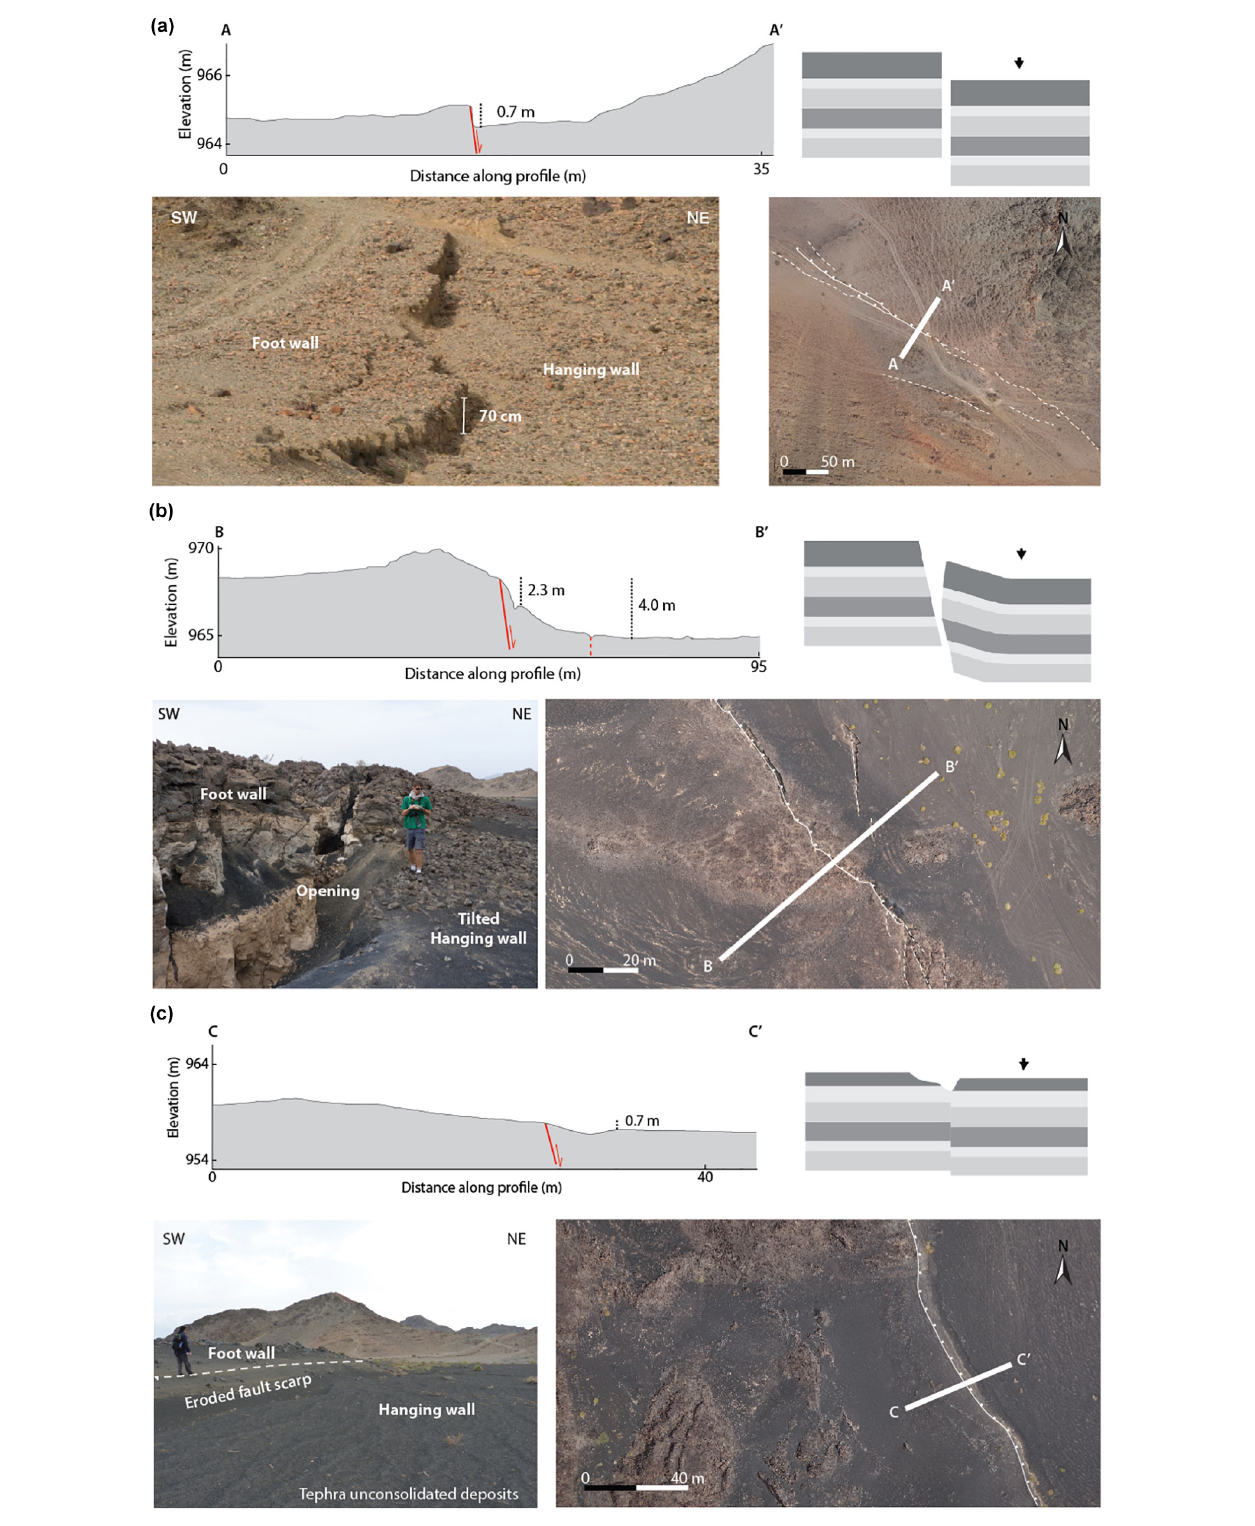
FIGURE 6 | Examples of fault offsets and geometries at three different locations along the western fault. The fault affects different lithotypes: cemented alluvium (a) , lava flow (b) , tephra (c) . For each location, we show the topography across the fault (from the drone DEM), a schematic model of the fault geometry, a field photo of the fault outcrop, an ortho-photo indicating the local rock lithology, the mapped fractures and the location of the topography profile.